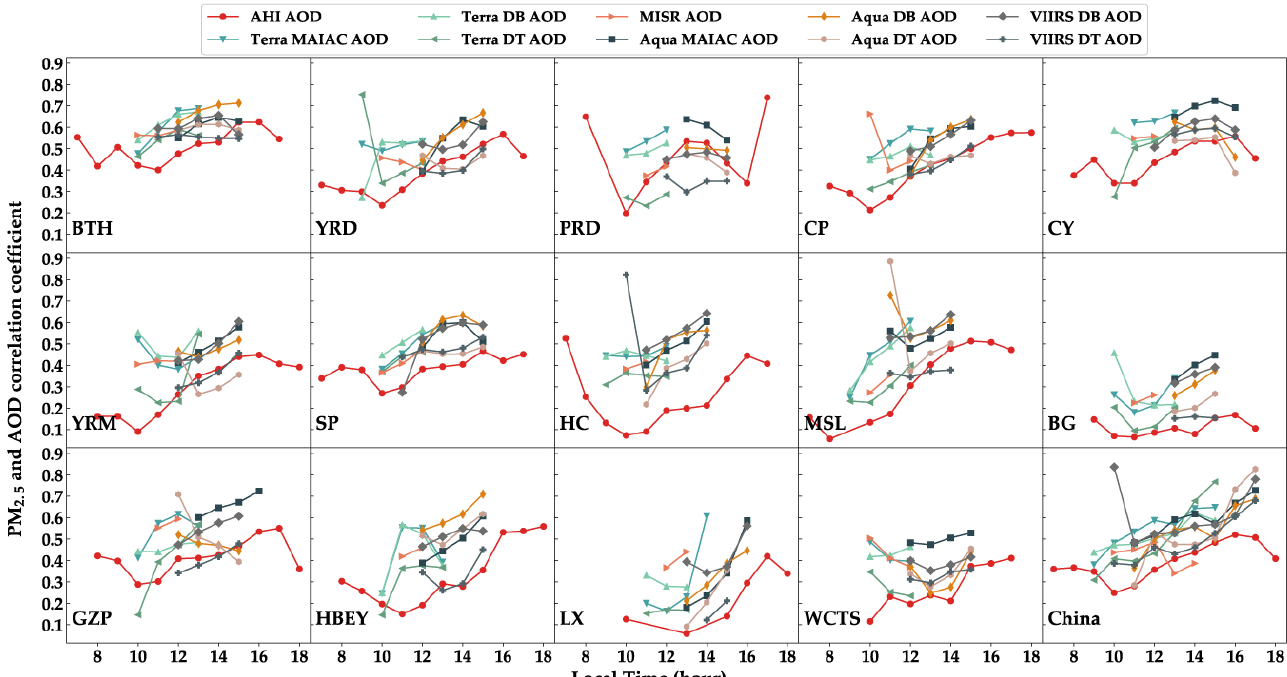
10 of 21 Figure 3. The spatial distribution of the PM 2.5 /satellite AOD ratio ( η ). Terra_MAIAC, Aqua_MAIAC, Terra_DB, Aqua_DB, Terra_DT, Aqua_DT, Terra_MISR, VIIRS_DB, and VIIRS_DT represent the same implication as in Figure 2. 3.2. Temporal Variation of the Relationship between Multiple AODs and PM 2.5 Based on the spatial-temporal collocations of AOD and PM 2.5 for the years 2016–2018, Figure 4 shows the daily variation of the correlation coefficients between the LEO/GEO satellite’s AODs and PM 2.5 . Since the AHI L3 AOD is an hourly aerosol product, it is pos- sible to determine the correlation coefficients with the ground-level PM 2.5 at the hourly scale using the collocations for the three years. In contrast, the maximum temporal reso- lution for the LEO satellite AODs, such as MODIS on the Terra and Aqua satellites, is only twice per day. It demonstrates that over the 14 typical urban agglomerations, the correla-